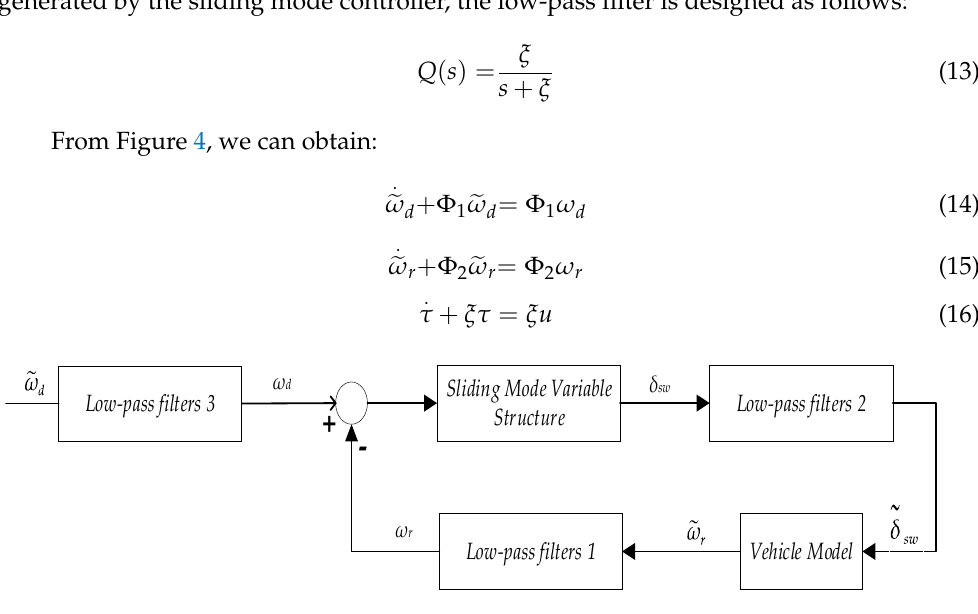
Figure 4. Sliding mode control systems based on low ‐ pass filters.